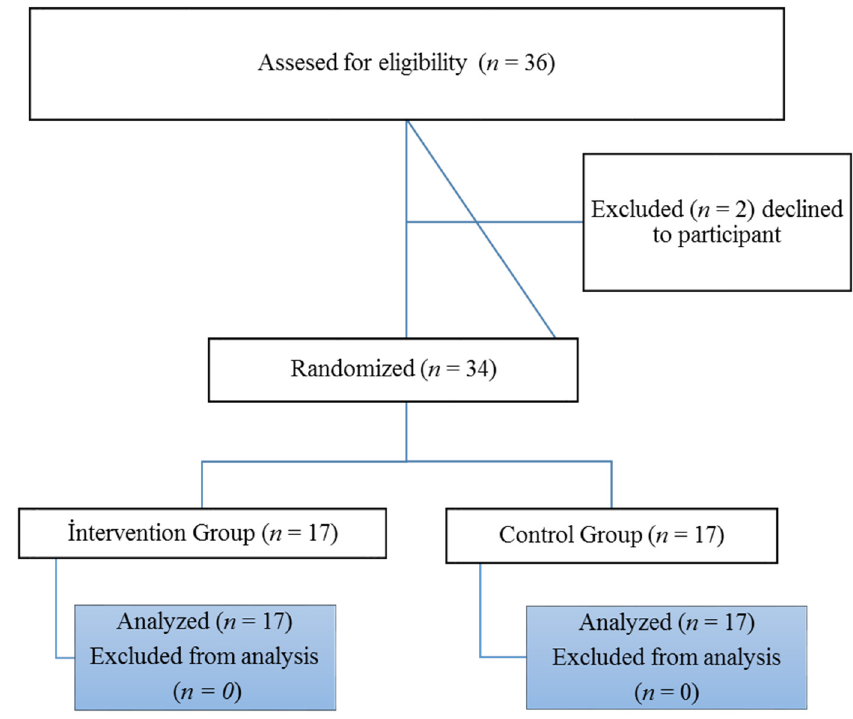
Figure 1. Flow diagram: the flow of during each trial phase.